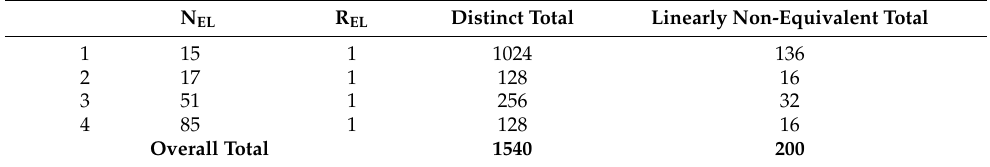
Figure 2. S-box Optimization Algorithm. Table 6. Linearly Non-Equivalent Functions for R EL =